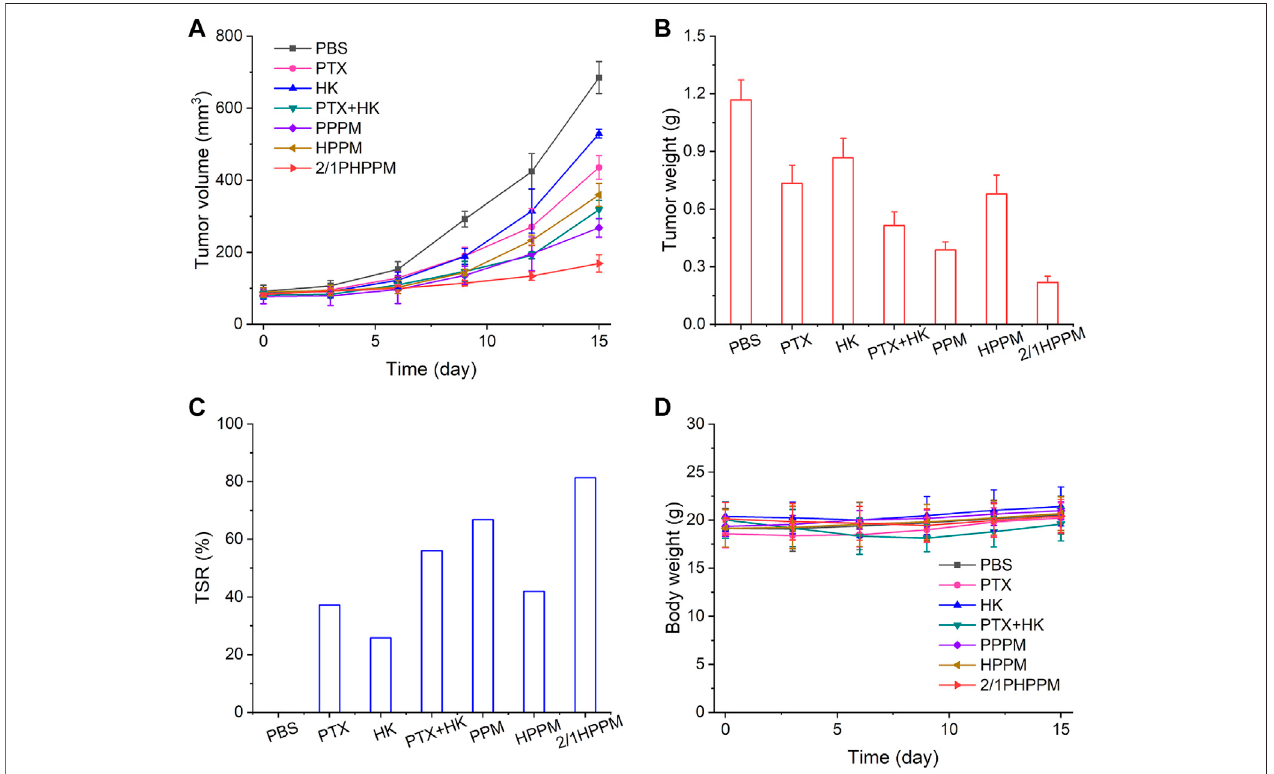
FIGURE 7 | In vivo tumor suppression ef fi ciency of different drug formulations. (A – C) time-dependent tumor volume changes (A) , tumor weight (B) , tumor suppression rate at day 15 (C) , and time-dependent mice body weight changes (D) in mice from different groups over 15 days ( n = 5). Data are represented as mean ± standard